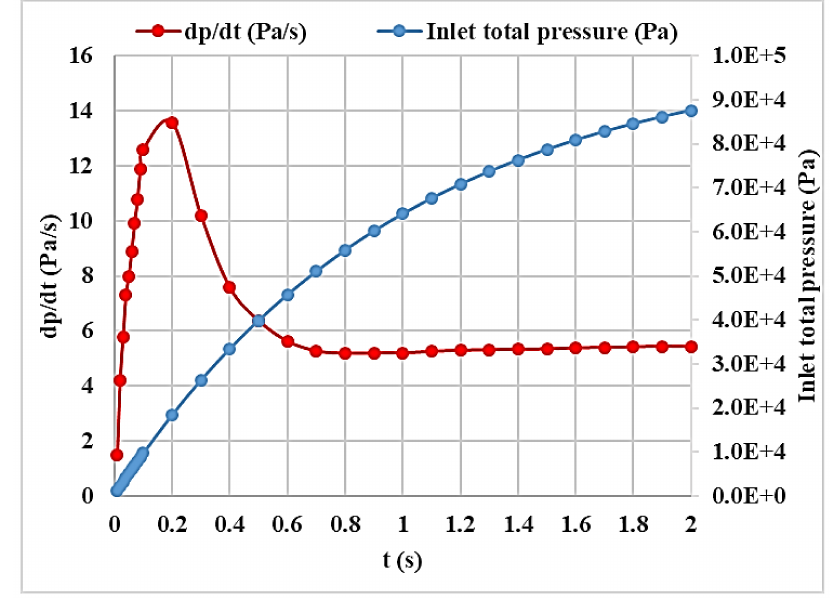
Figure 10. Mean pressurisation rate and inlet total pressure versus